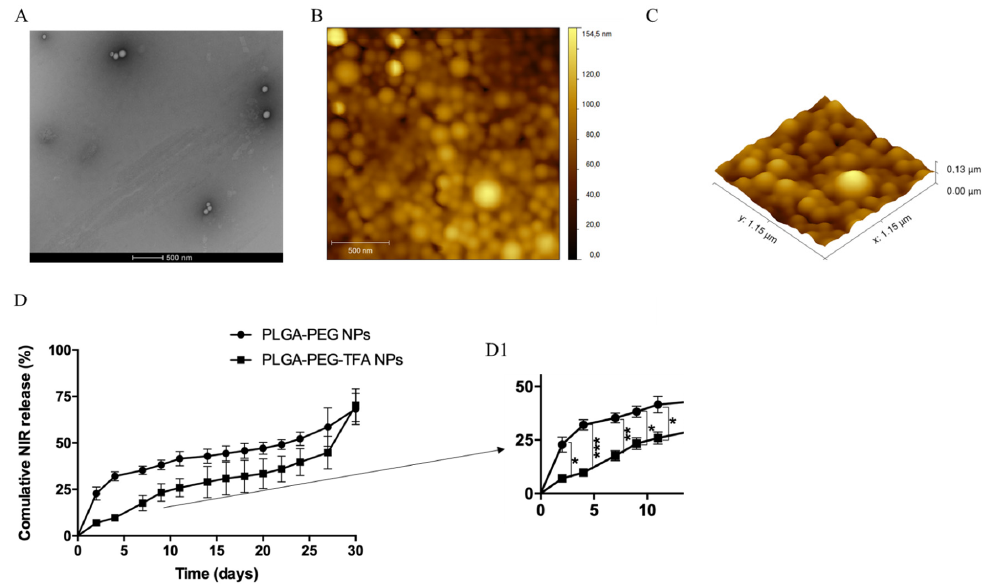
Figure 3. Characterization of PLGA-PEG-TFA NPs with ( A ) images of nanoparticle (NP) morphology obtained by TEM; ( B ) AFM 2D image; and ( C ) AFM 3D image of functional PLGA-PEG-TFA NPs. ( D ) Cumulative release study of NIR dye in PBS solution from PLGA-PEG and PLGA-PEG-TFA NPs. ( D1 ) Zoom image of the cumulative release study of NIR dye with the significant differences. Asterisks indicate significant difference in Student’s t -test, * p < 0.05, ** p < 0.01, *** p <